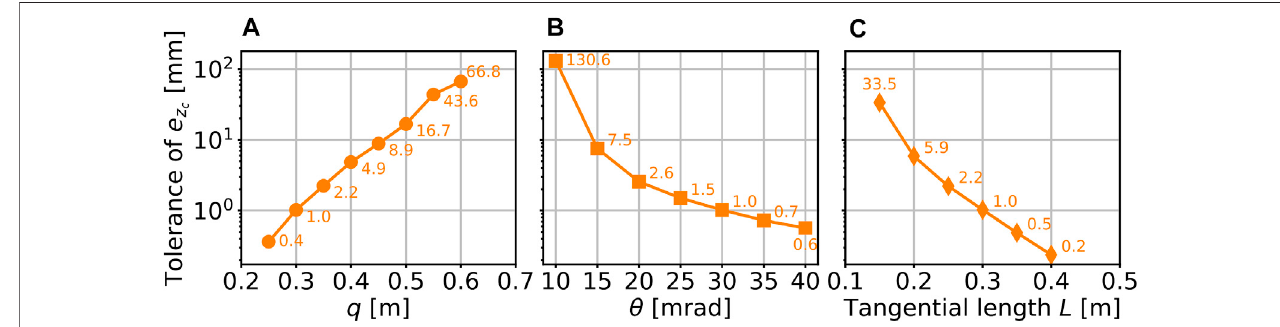
FIGURE 6 | Tolerance of e z becomes tighter when the ellipse becomes more “ extreme ” . From the default ellipse, change one parameter at atime: (A) the q value, c (B) the θ value, (C) the length of the optical area.